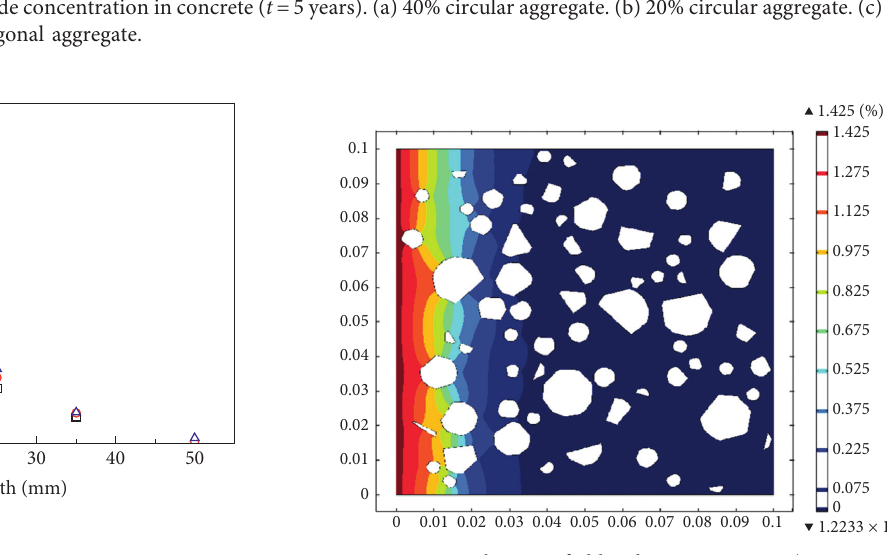
Figure 5: Distribution of chloride concentration ( t �